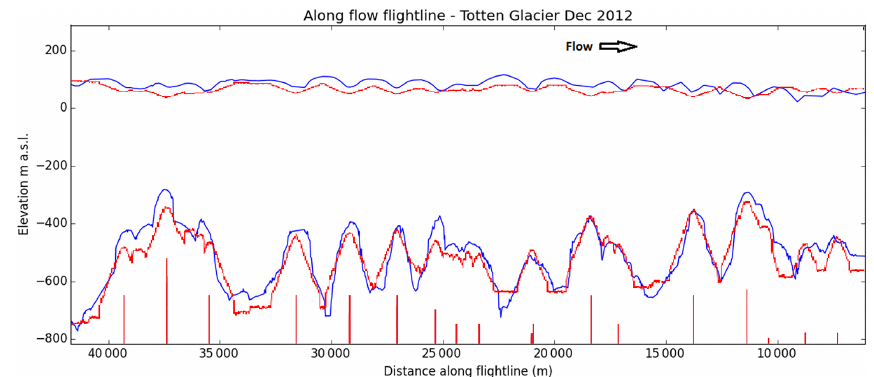
Figure 4. Evolution of basal fracture geometry under ocean melt. The KPZ equation is used to evolve an initial set of narrow fractures (vertical lines at the bottom of the figure) under constant basal melt. The computed surface and base after 100 years (red) can be made to match the measured geometry along ICECAP flight path ASB/JKB2h/GL0196b (dark